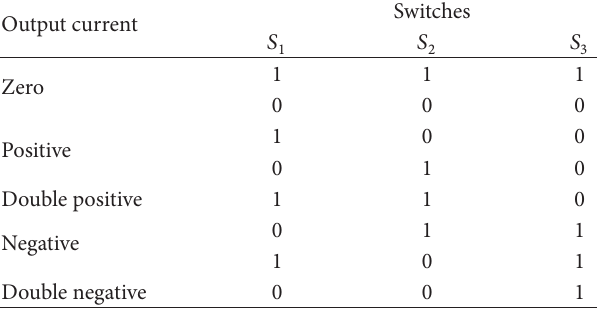
Table 1: Switching states of the